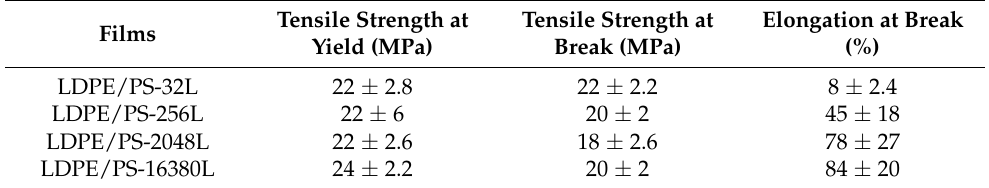
Figure 6. Engineering stress-strain plot of LDPE/PS multilayer 50/50 (wt/wt) films with different numbers of layers in the machine direction. Table 5. Mechanical properties of the LDPE/PS 50/50 (wt/wt) films with different numbers of layers.